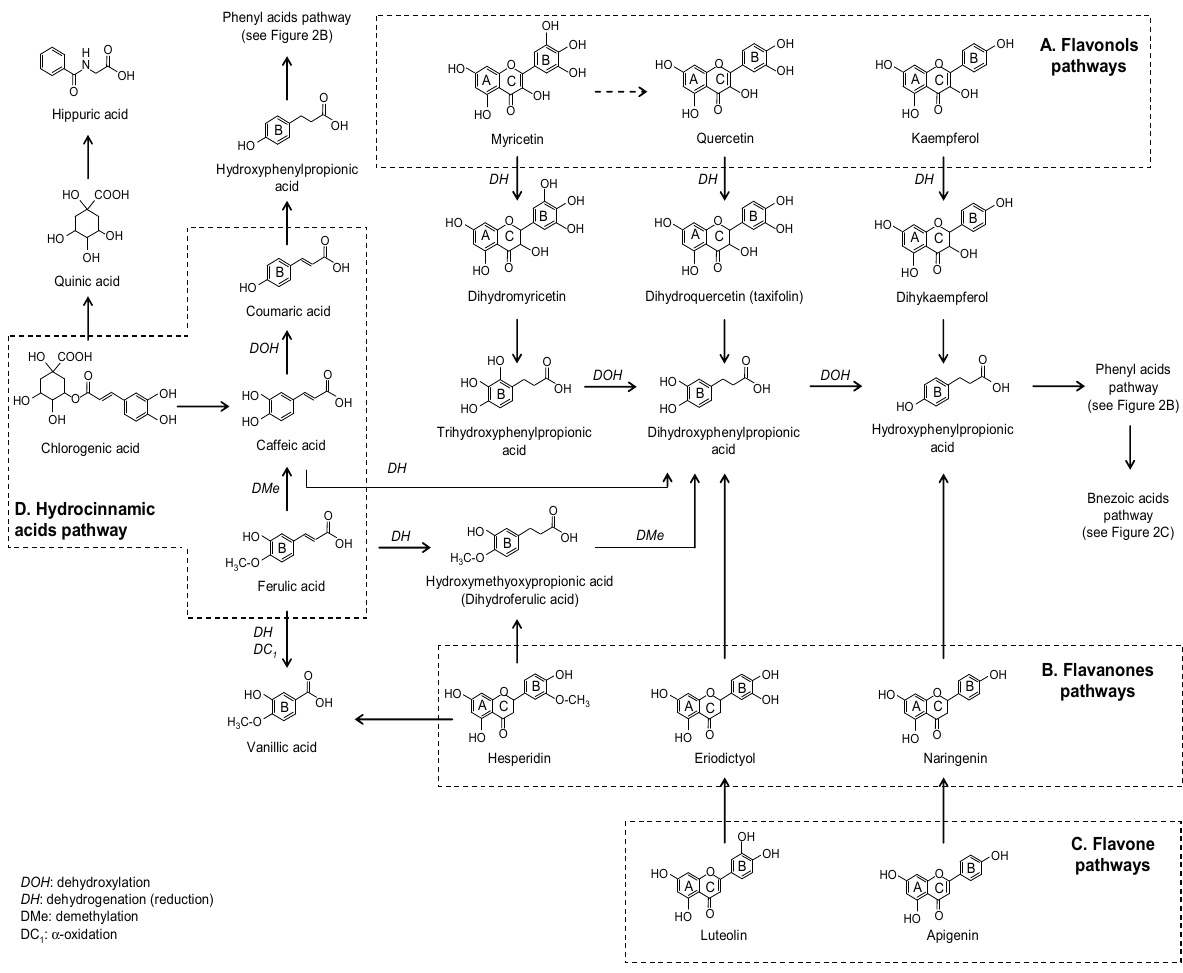
Figure 3. Proposed colonic pathways of flavonols, flavanones, flavones, and hydrocinnamic acids. The flavanones hesperetin and naringenin are found in larger concentration in oranges, whereas eriodictyol is a flavanone commonly presented in aromatic herbs and nuts. Hydroxyphenylpropionic and phenylpropionic acids have been described as major fermentation products of eriodictyol